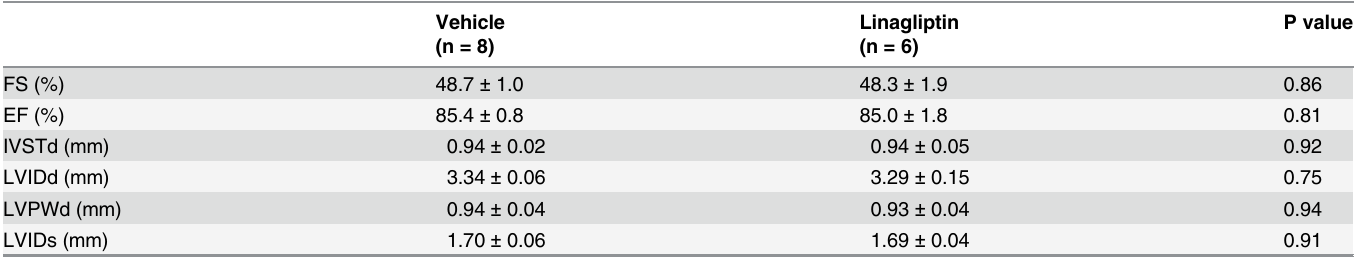
Table 1. Echocardiography on day 21.